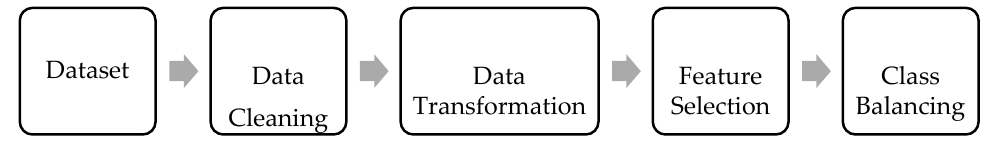
Figure 5. Data pre-processing steps.